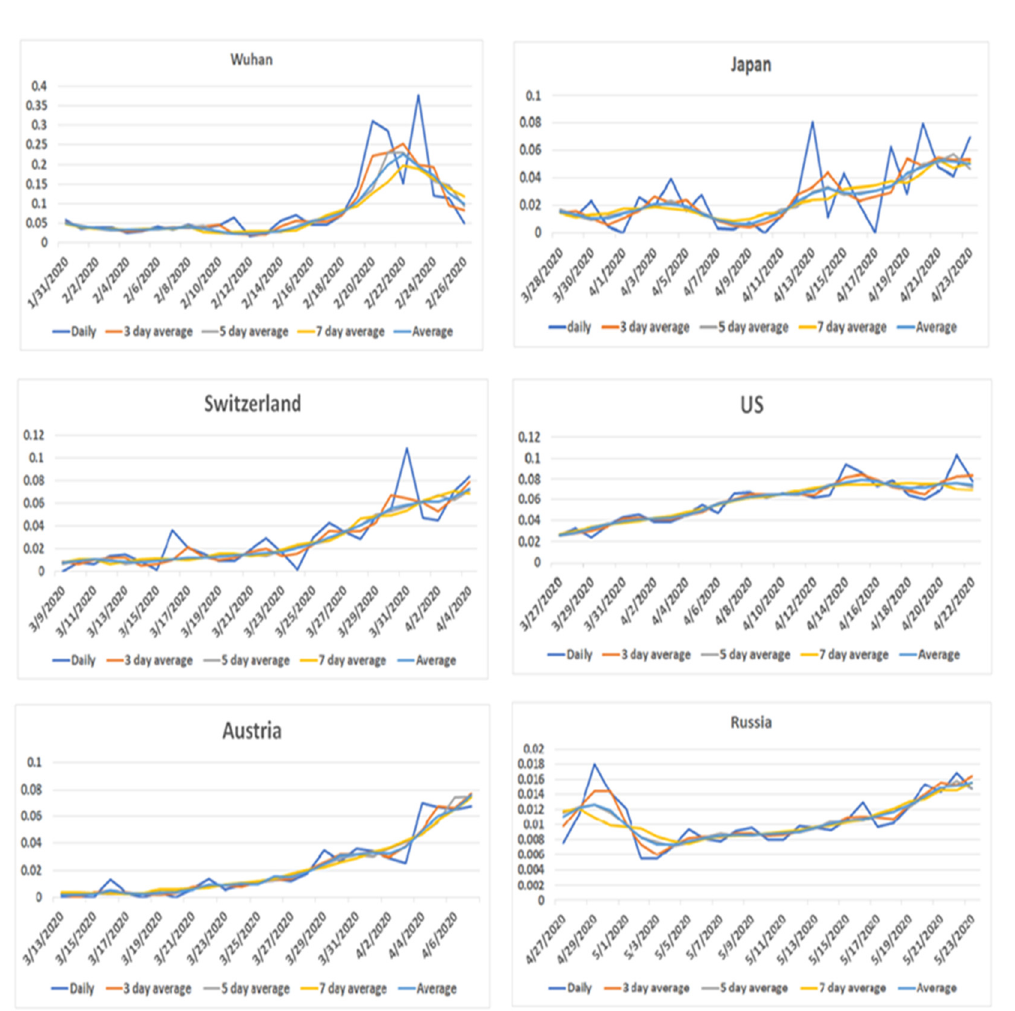
Figure 4. The graphic trajectory comparing COVID-19 death rates between Wuhan and five countries. X-axis represents date of observations. Y-axis indicates the death rate (%). Daily, 3-day average, 5-day average, 7-day average are the average death rates of every day, 3 days, 5 days, and 7 days. The average means the average death rates of daily, 3 days, 5 days, and 7 days in total.